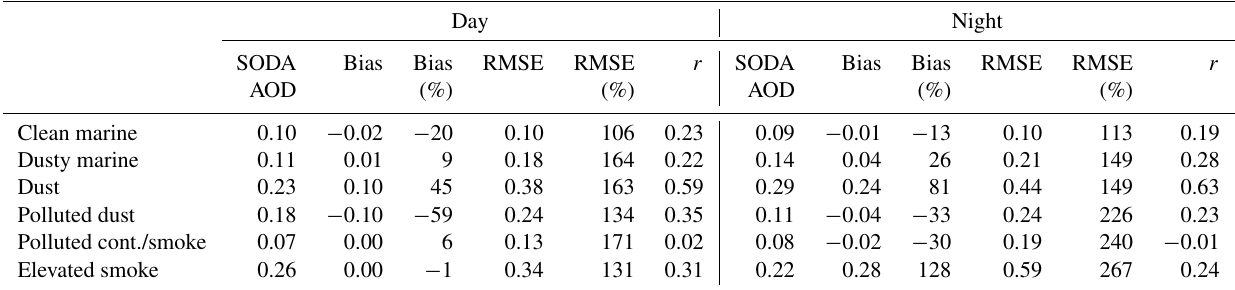
Table 3. AOD statistics: V4-SODA absolute and relative biases (in %) root mean square error (RMSE) and fractional RMSE (in %), and linear correlation coefficient r . Percentage values are relative to the mean SODA